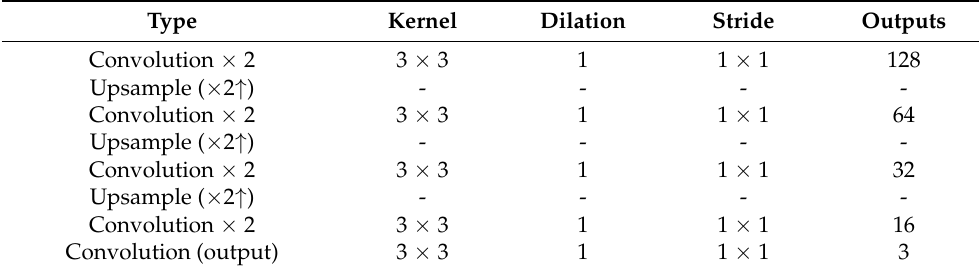
Table 2. Detailed architecture of parallel decoding